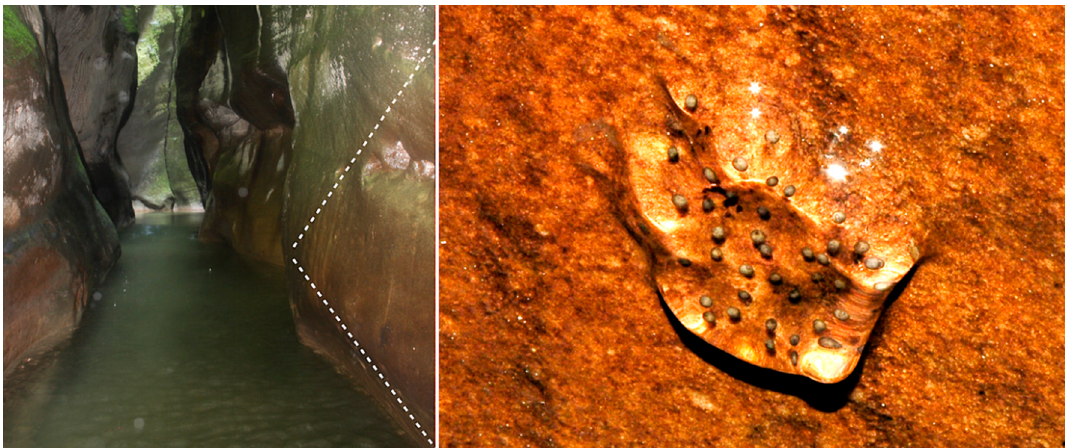
Figure 192. Left : Habitat of a glassfrog tentatively assigned to Rulyrana flavopunctata or R. mcdiarmidi . Right : Egg clutch of the rock walls of the river. Locality: Río Tayuntza, Cuevas de los Tayos, Río Tayuntza, Morona Santiago province, Ecuador. Photos by Octavio Jiménez-Robles (left) and Ignacio de la Riva (right) . Modified from Jiménez-Robles et al. [280].